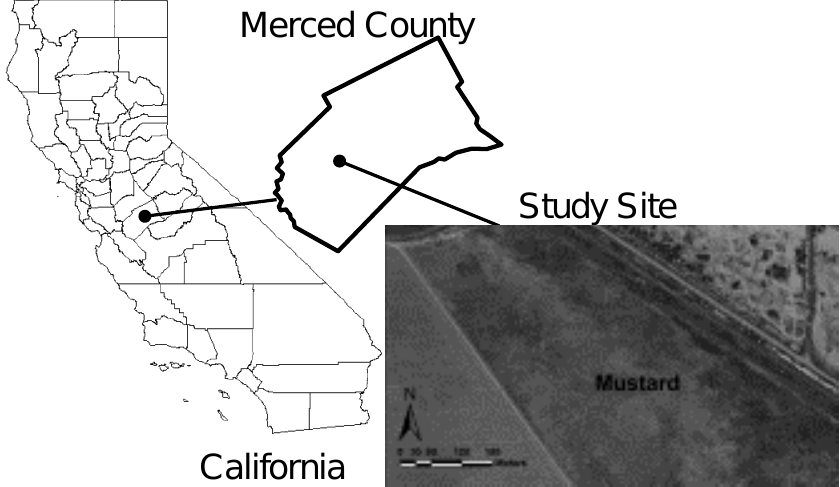
Figure 2. Map showing the location of the 16.2-ha field in California’s Merced County.